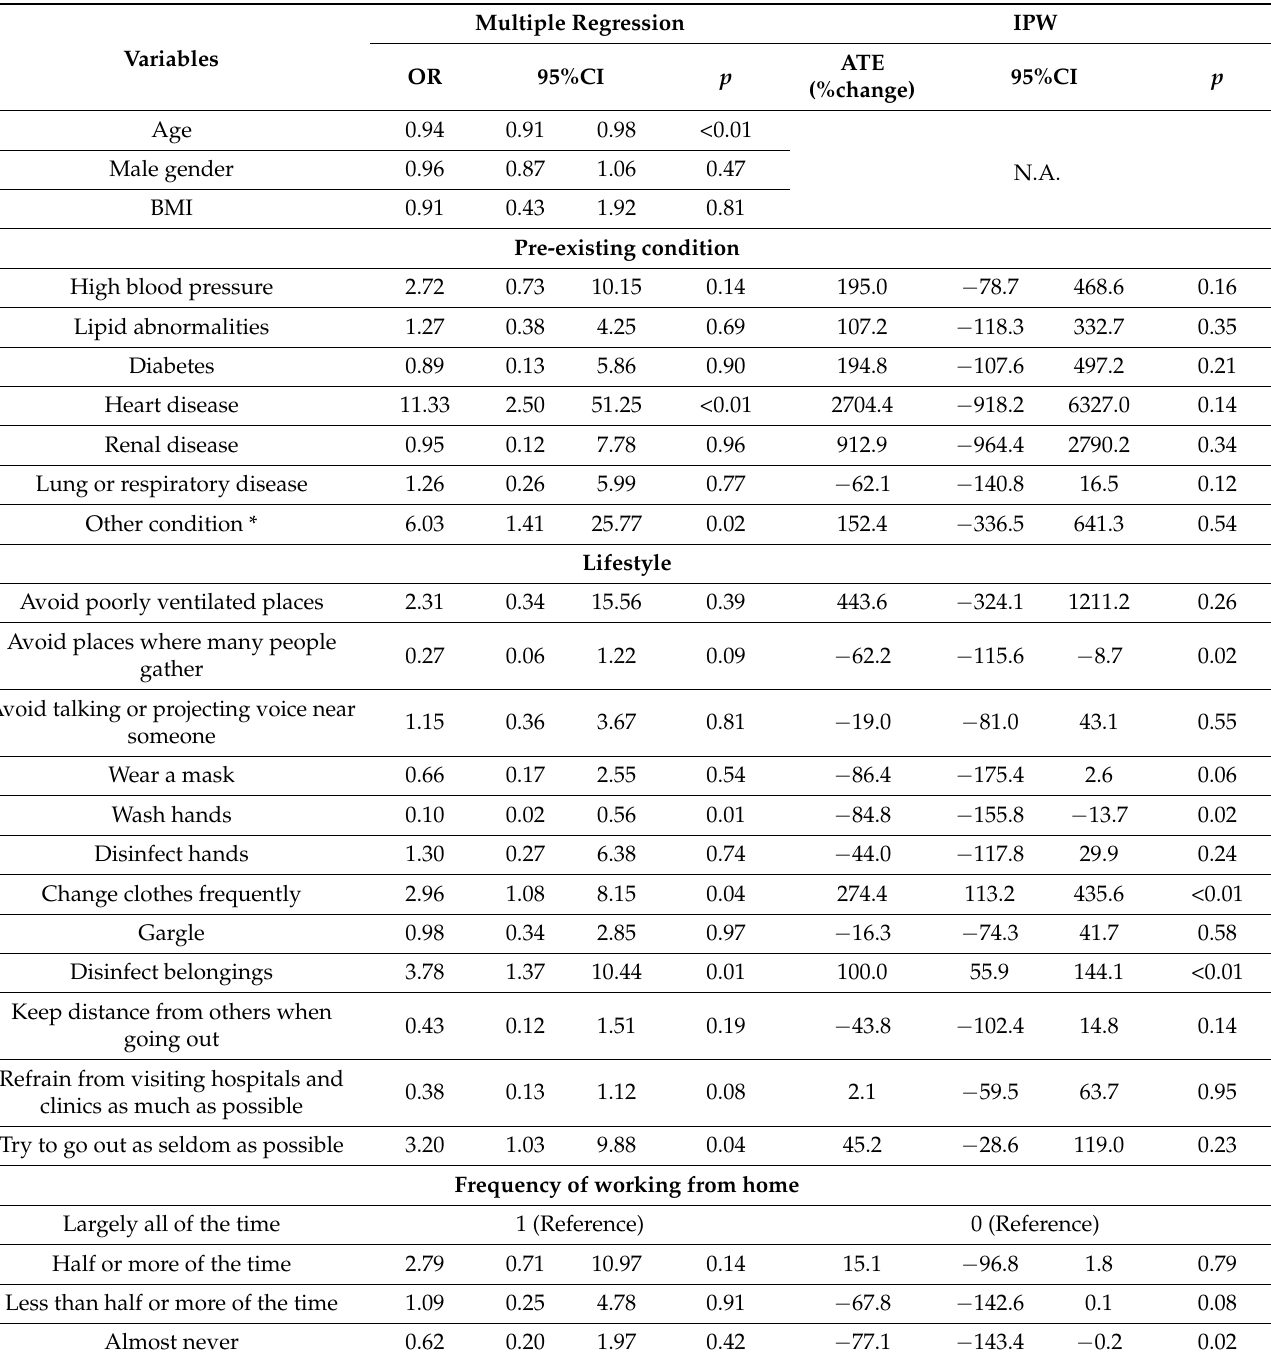
Table 2. Comparisons of COVID-19 and control groups using two statistical methods. Multiple logistic regression (left column) and inverse-probability weighing method (IPW, right column) were conducted. IPW was controlled for age